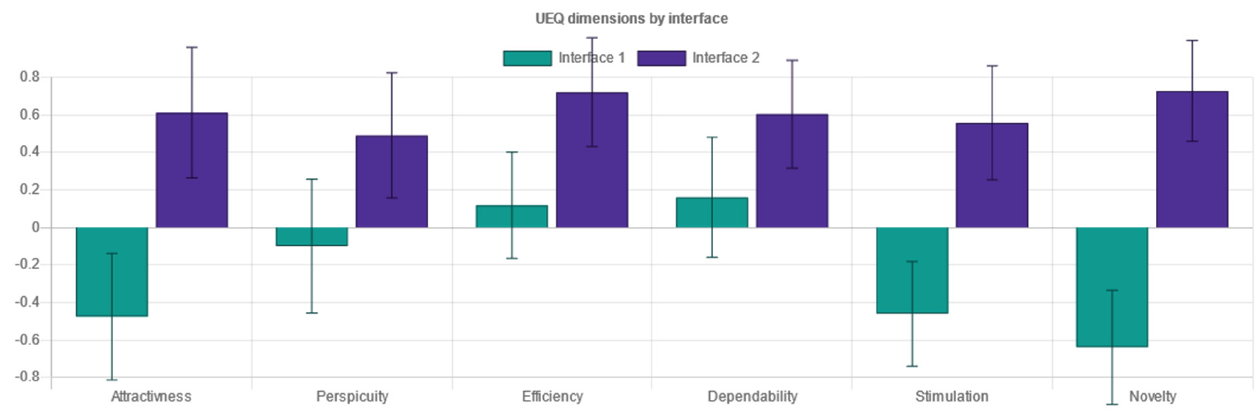
Figure 10. UEQ dimensions by interface.